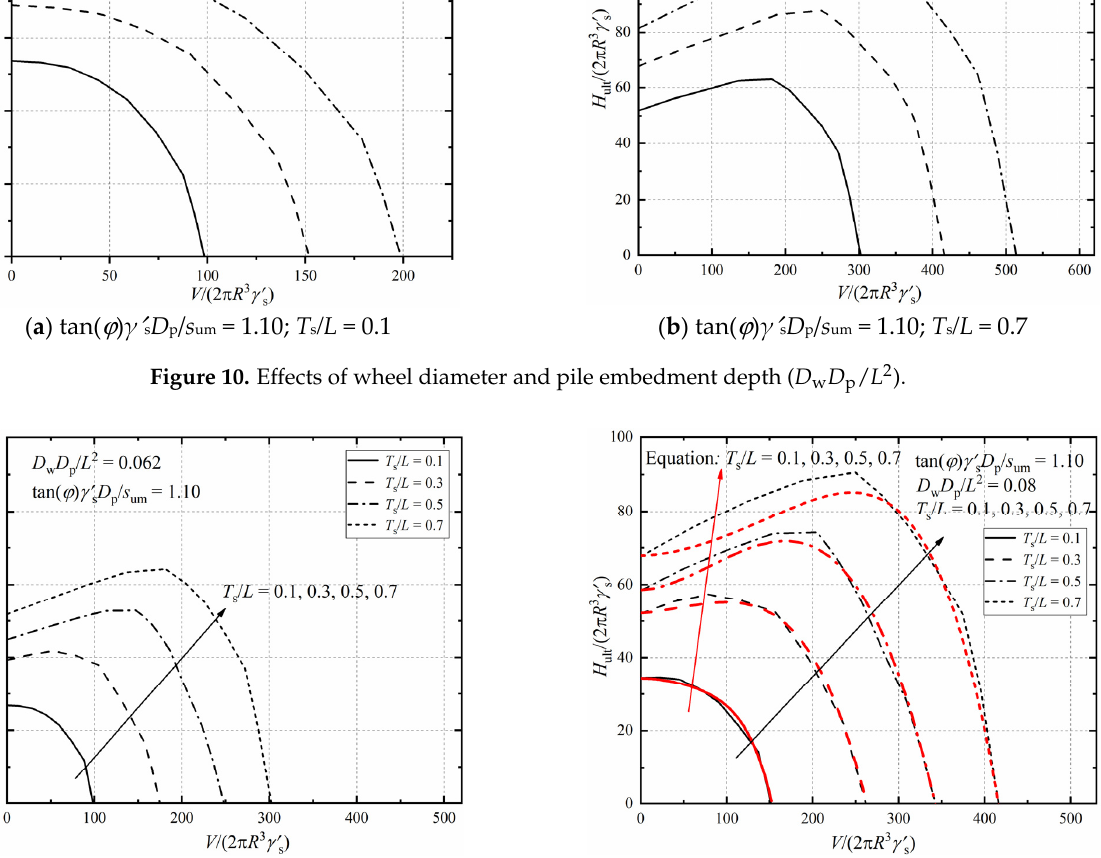
Figure 11. Effects of sand layer thickness ( T s / L ).